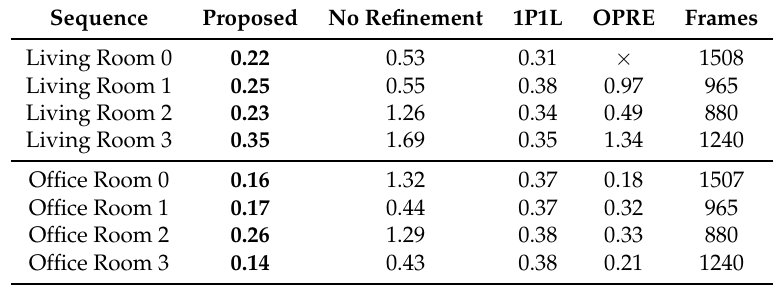
Figure 6. Results of camera orientation estimated by our proposed method on the ICL-NUIM dataset: ( a ) ‘Living Room 0’ sequence. ( b ) ‘Office Room 0’ sequence. The estimated orientation of each frame is shown in the bottom of the RGB image. Colored thick and thin lines respectively denote current orientation and global MW axes (determined in the first frame); black lines represent ground orientation. Table 1. Comparison of average absolute rotation error (ARE, degrees) on the ICL-NUIM dataset. Sequence Proposed No Refinement 1P1L OPRE